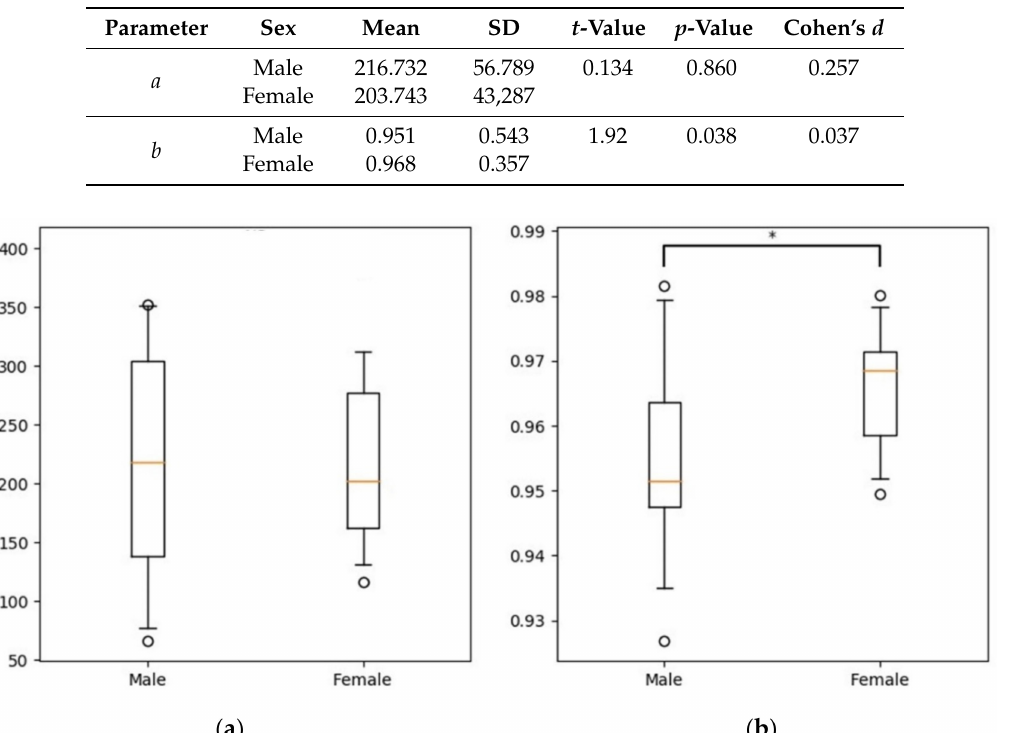
Table 5. Statistics results of parameters a and b .